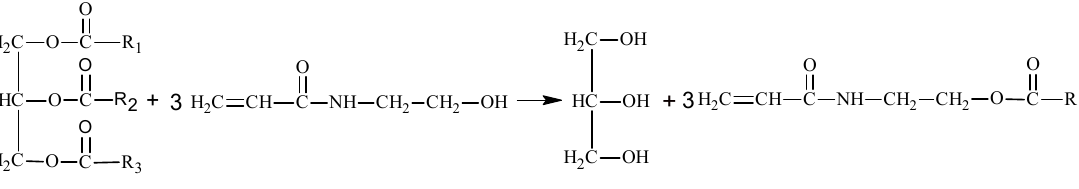
Figure 4. Schematic of synthesis of acrylic monomers based on plant oil triglycerides where R 1 , R 2 , R 3 are saturated and unsaturated fatty acid chains with one or several double bonds. Reprinted with permission from [10]. Copyright (2015) American Chemical Society.